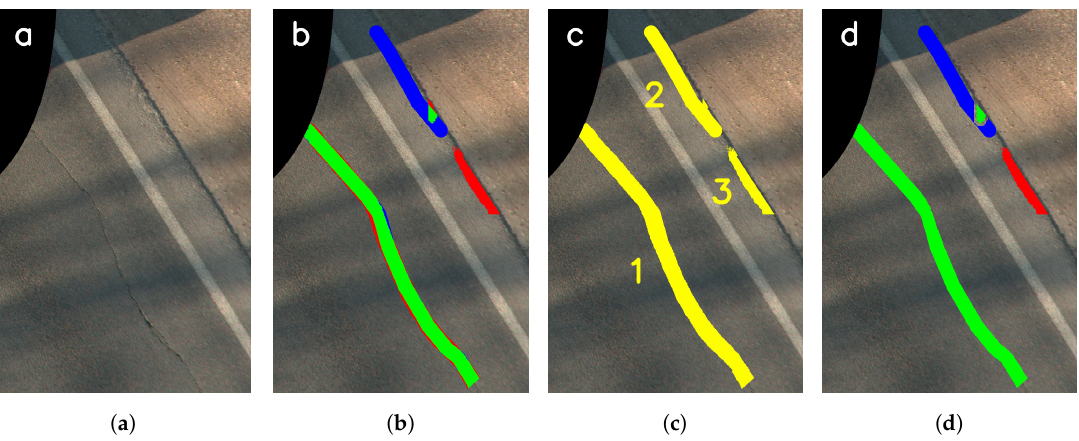
Figure 9. An illustration of various metrics. ( a ) The original image; ( b ) TP, FN and FP pixels are depicted by colors of green, blue and red, respectively; ( c ) Three objects obtained by combining the predictions and ground truth instances; ( d ) TP, FN and FP pixels with edge-tolerant intersection over union (IoU)